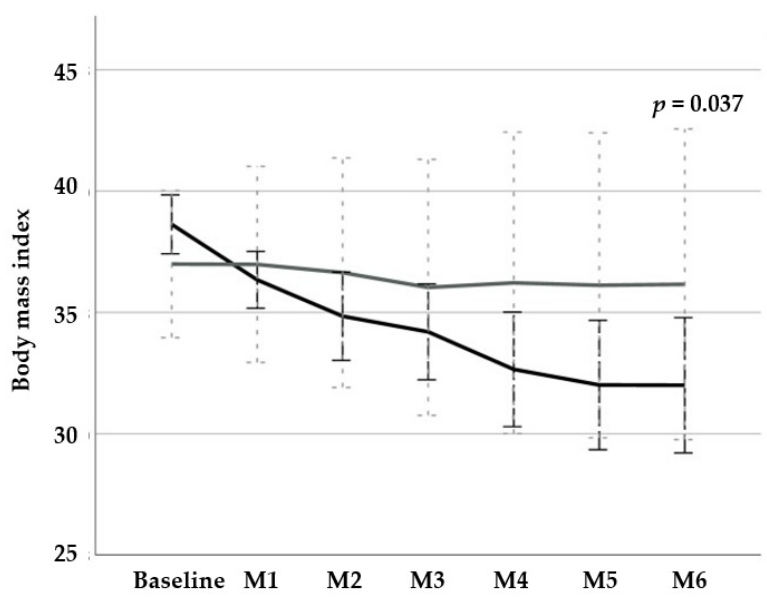
Figure 3. Plot displaying dynamics of body mass index values at baseline and during the 6-month follow-up period in the study population. Black line: very low calorie ketogenic diet; grey line: Mediterranean diet; M: month.